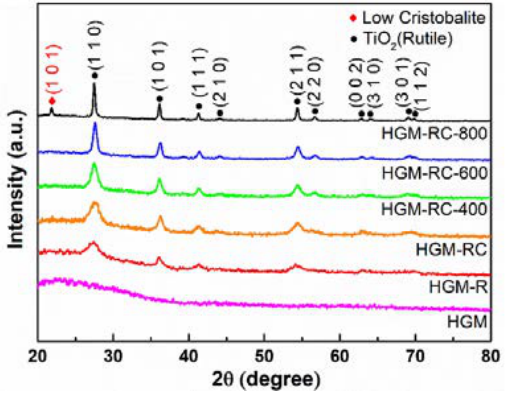
Figure 2. XRD patterns of the pristine HGM and the TiO 2 -coated HGM.